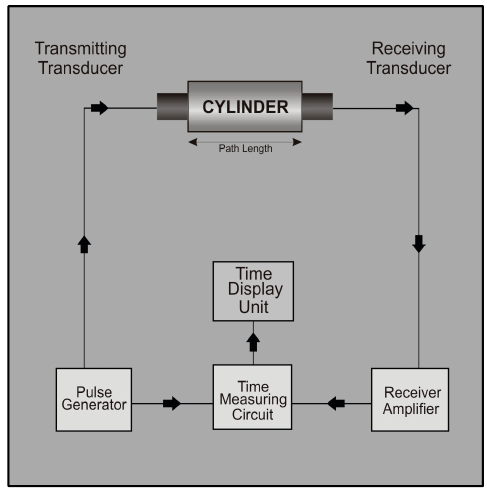
Figure 2. Schematic diagram of ultrasonic pulse velocity.